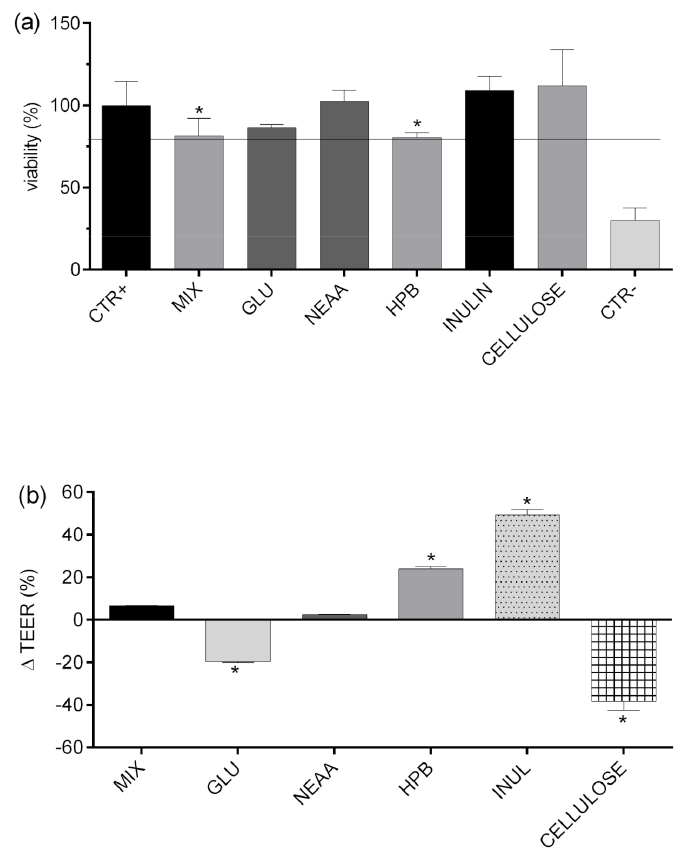
Figure 4. Viability (%) of Caco-2 cell monolayer determined by MTT test after exposure to analyzed food fractions ( a ). Relative change (%) of TEER values during the experiment ( b ). positive control (CTR + )—HBSS;MIX—TS + HTS(40mg / L);EDTA(10 µ M);GLU—glucose(10mM);NEAA—non-essential amino acids (0.25%); HPB—hydroxypropyl beta-cyclodextrin (2.4 g / L); CELLULOSE—cellulose